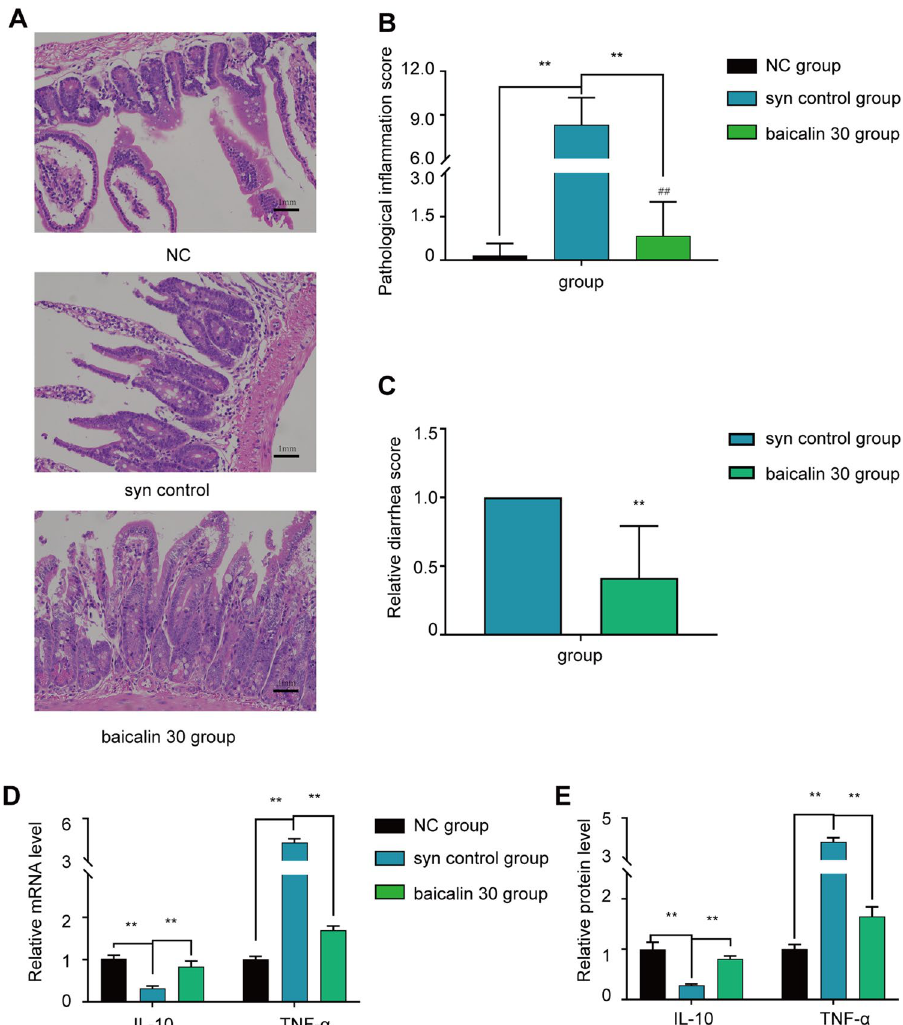
Figure 5. Mouse small intestinal pathology and inflammatory factor levels. There were 6 mice in the normal control group, and the other groups had 10 mice in each group. ( A ) Representative intestinal histological images of each experimental group on the 15th day (H&E staining, 200×). ( B ) Analysis of the mouse small intestine pathological score on the 15th day. ( C ) Diarrhea score of each group on the 15th day. ( D ) mRNA levels of the inflammatory factors IL-10 and TNF-α in the experimental group on the 15th day. ( E ) Protein levels of the inflammatory factors IL-10 and TNF-α in the experimental group on the 15th day. The data are presented as the mean ± SD. Every experiment was repeated in triplicate. ** P < 0.01 compared with the aGVHD control